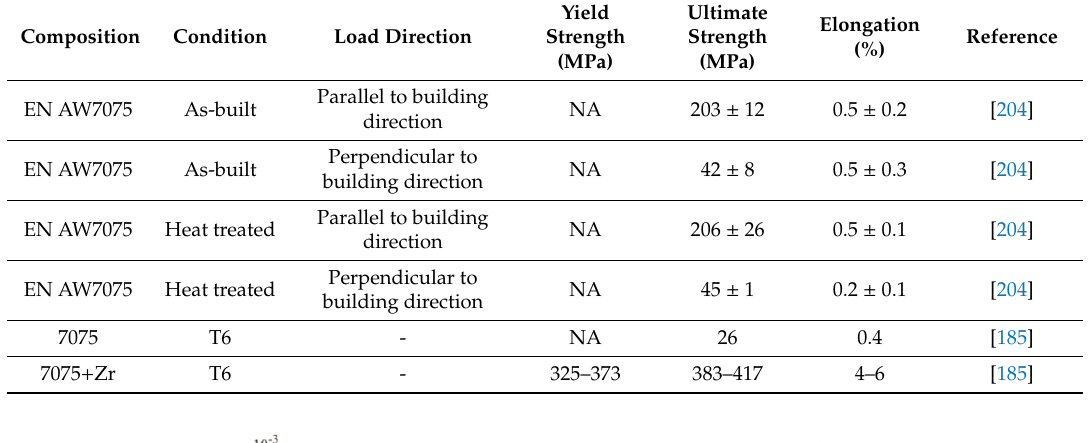
Table 5. Mechanical properties of SLM 7075 alloys under different loading conditions.